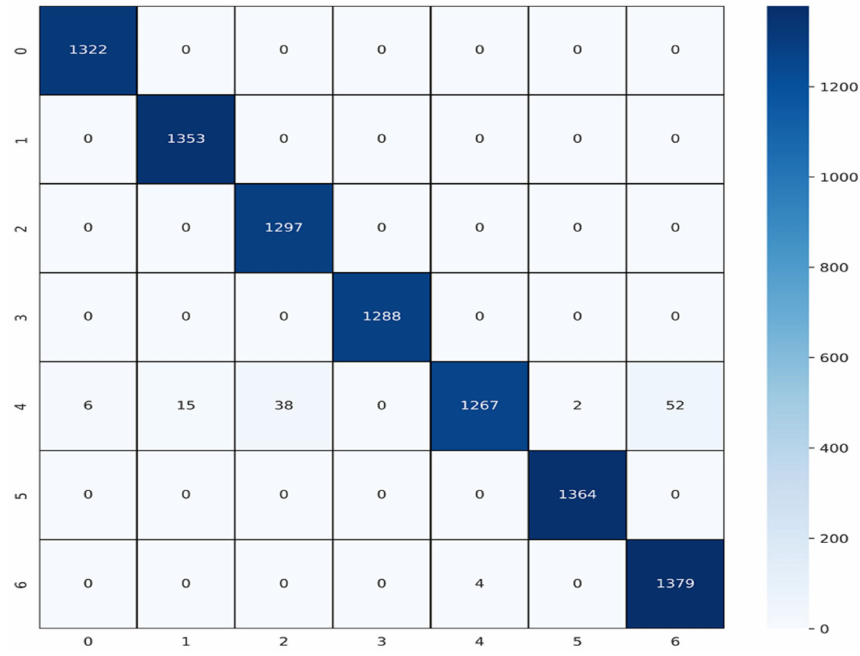
Figure 6. Confusion matrix for protocol-I (80:20 Train:Test split). Table 7. Class-wise performance measures of the model.